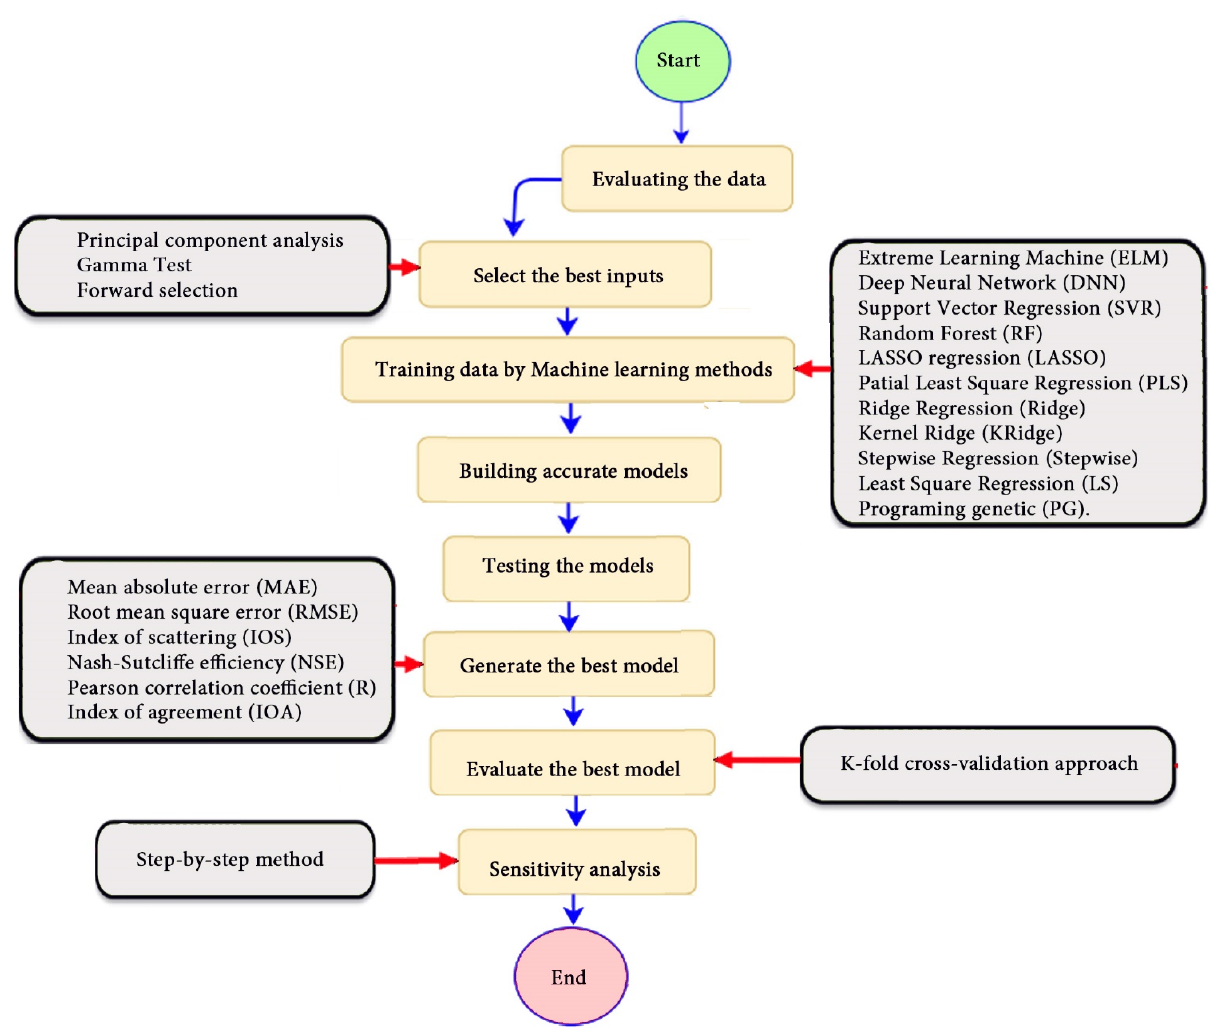
Figure 3. Flowchart of key steps for the research methodology to estimate C s .